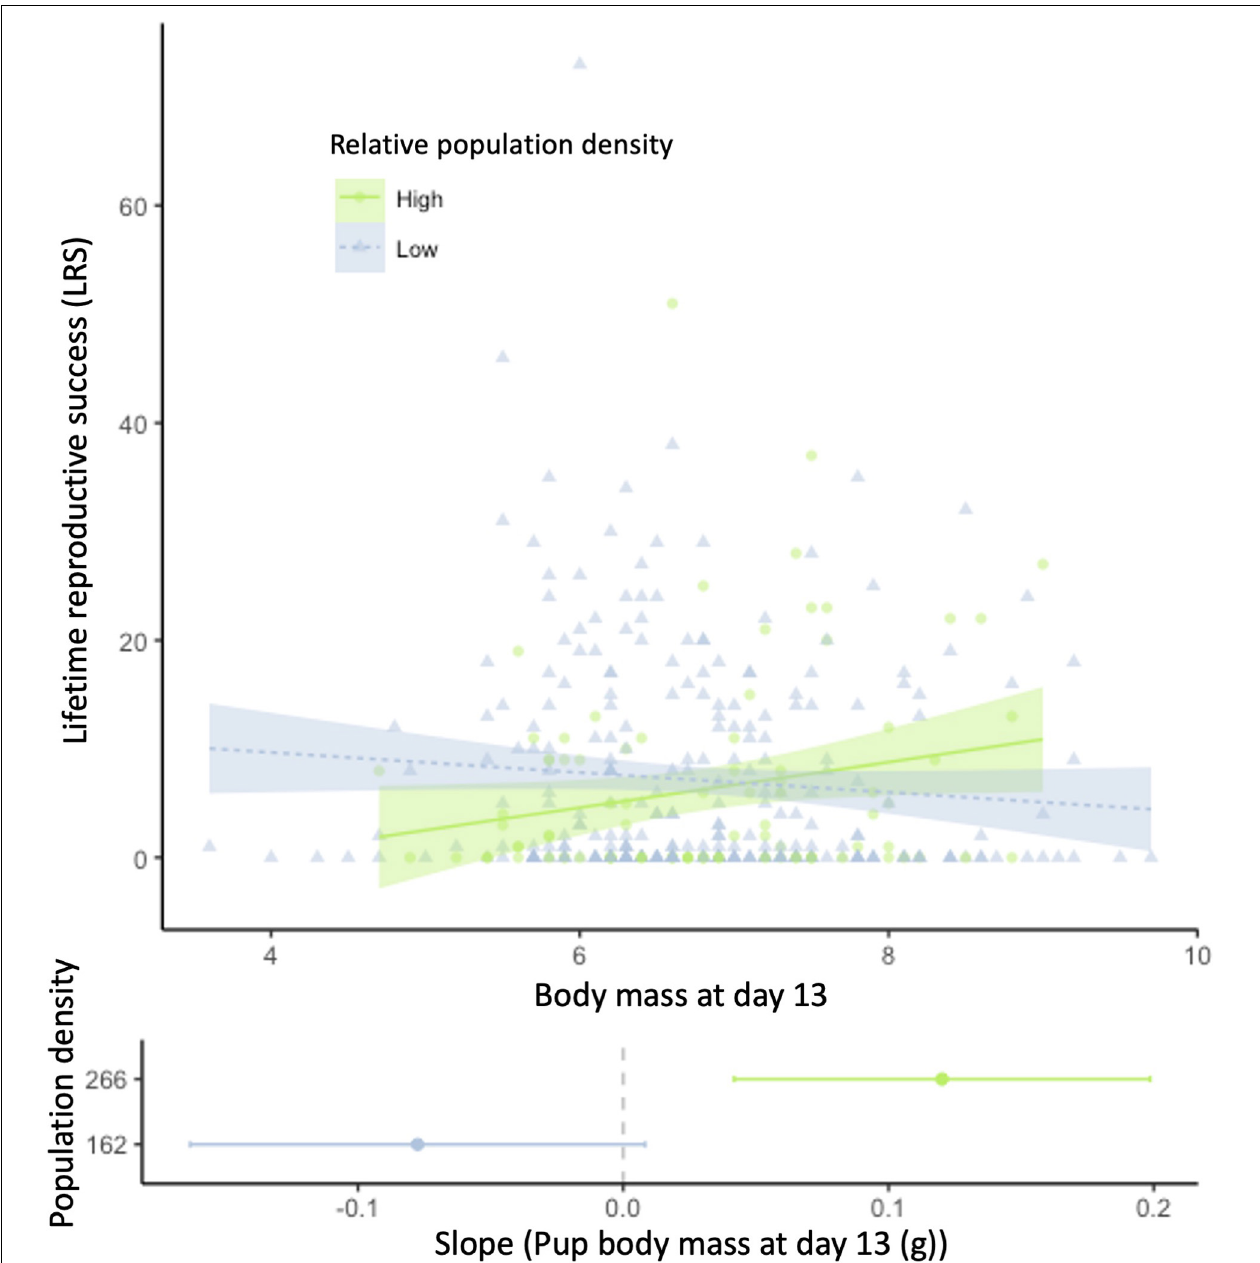
FIGURE 3 | Relationship of lifetime reproductive success (LRS; number of offspring surviving until day 13) with body mass as pup at day 13. The shaded areas indicate the 95% confidence intervals. Population density was categorized for the figure and the slope analysis with high population density above the 0.75 quantile and low population density below the 0.25